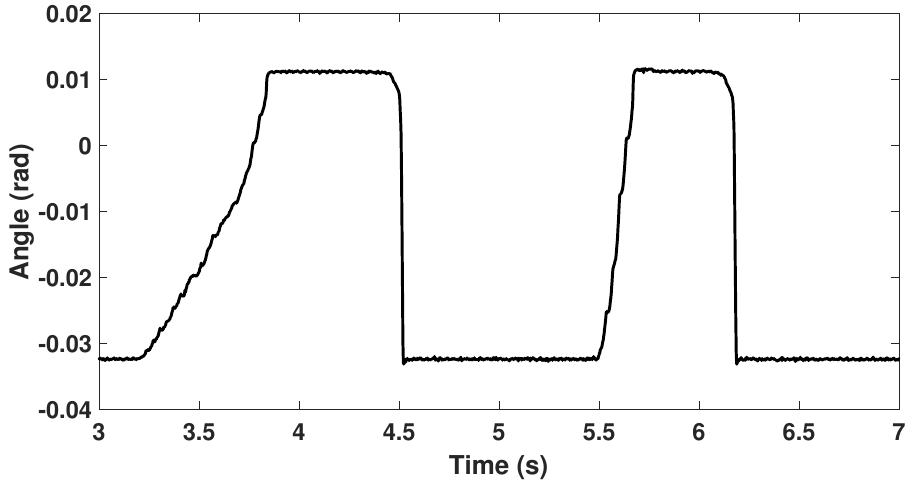
Figure 17. Key position applied for actuator